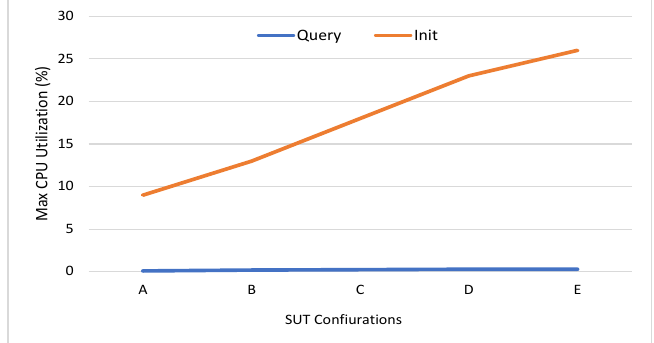
Figure 8. Maximum CPU usage of endorsing peer